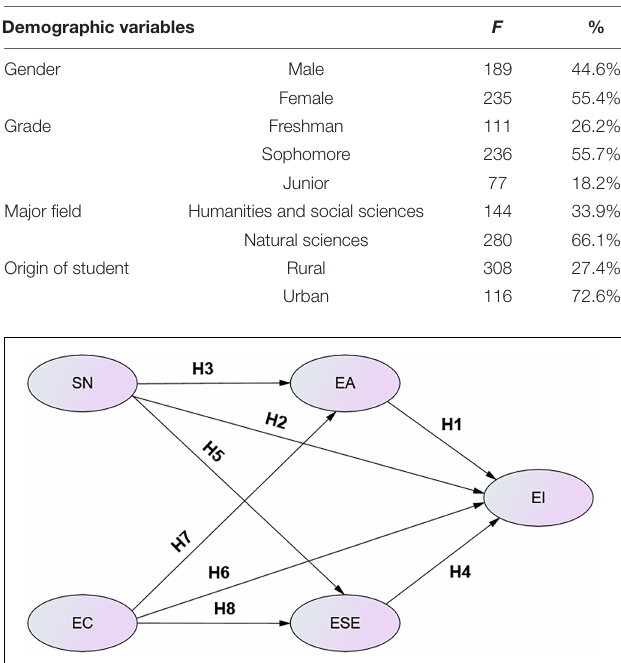
FIGURE 1 | Conceptual framework. SN, subjective norms; EA, entrepreneurial attitude; ESE, entrepreneurial self-efficacy; EI, entrepreneurial intention; EC, emotional